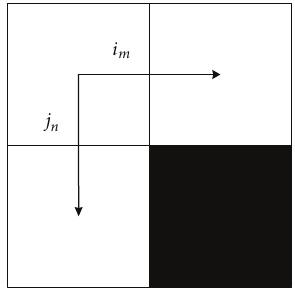
Figure 3: The distance between two grids on the X-axis and Y-axis. i represents the coordinates of the current grid on X-axis, and j represents the coordinates of the current grid on Y-axis. In order to calculate the distance between arbitrarily two grids, m represents the coordinates of the surrounding grid on X- axis, and n represents the coordinates of the surrounding grid on Y-axis. When the condition (1) is satisfied, the direction of the next motion will be the upper, or lower, or left, or right directions. When condition (2) holds, it will be the upper left, lower left, upper right, or lower right directions.